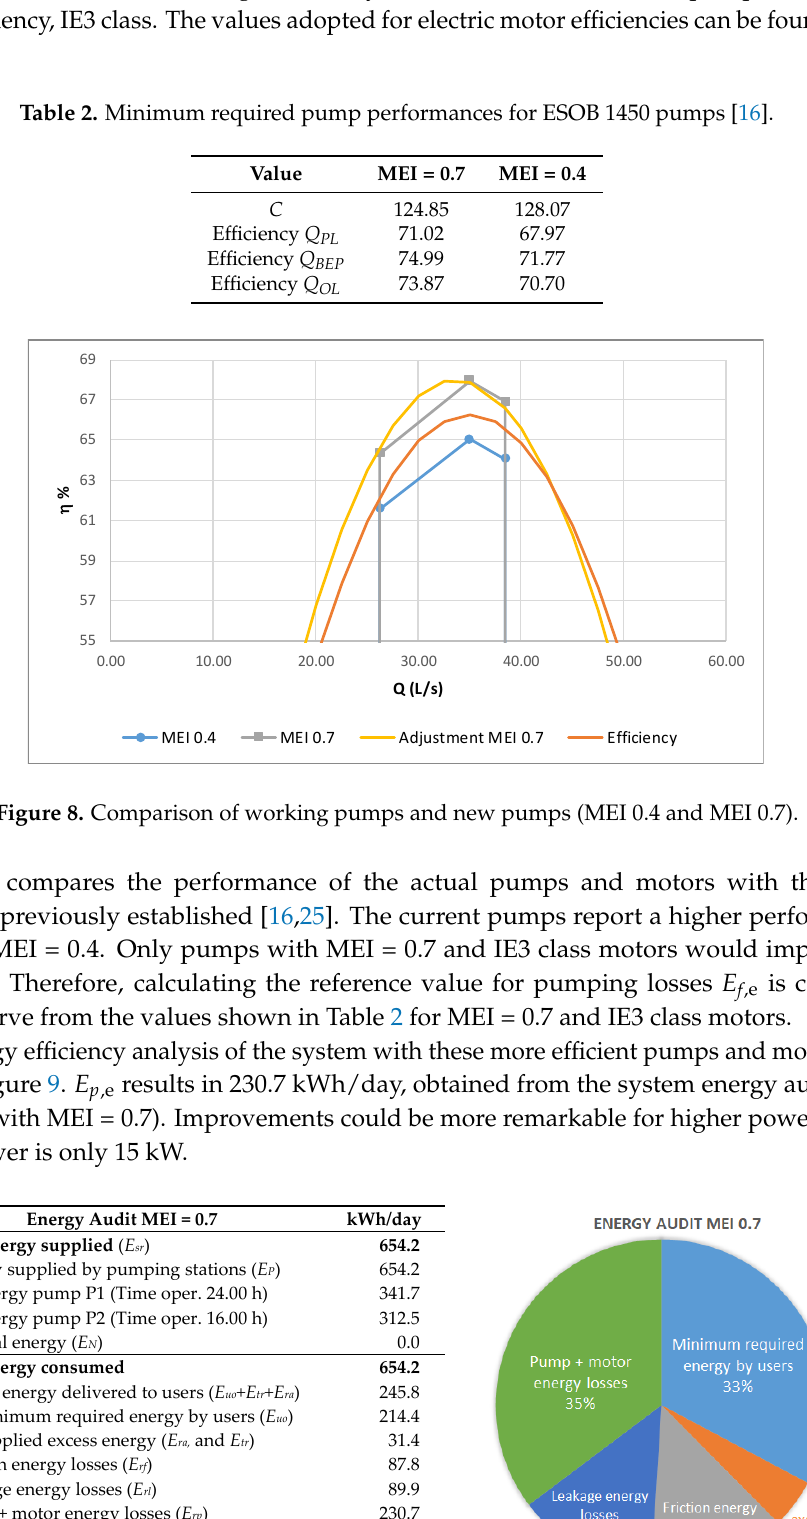
Table 2. Minimum required pump performances for ESOB 1450 pumps [16].